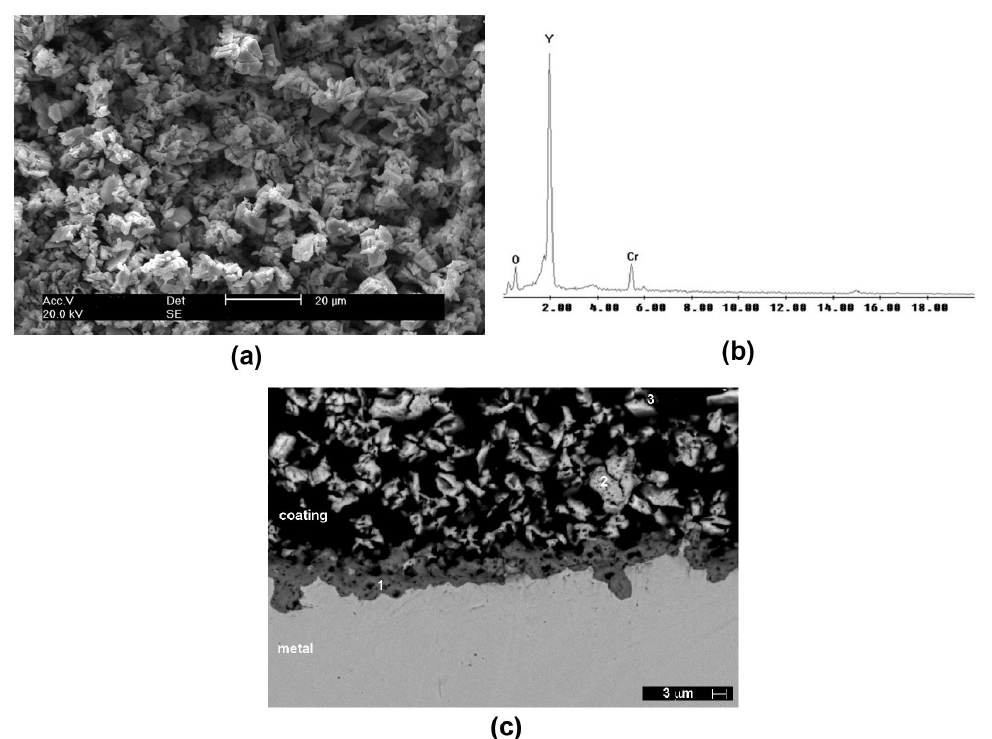
Figure 7: Scanning electron micrographs and the EDS spectrum of Y 7 h at 1000 °C. (a) The surface; (b) the EDS spectrum of the surface; (c) the